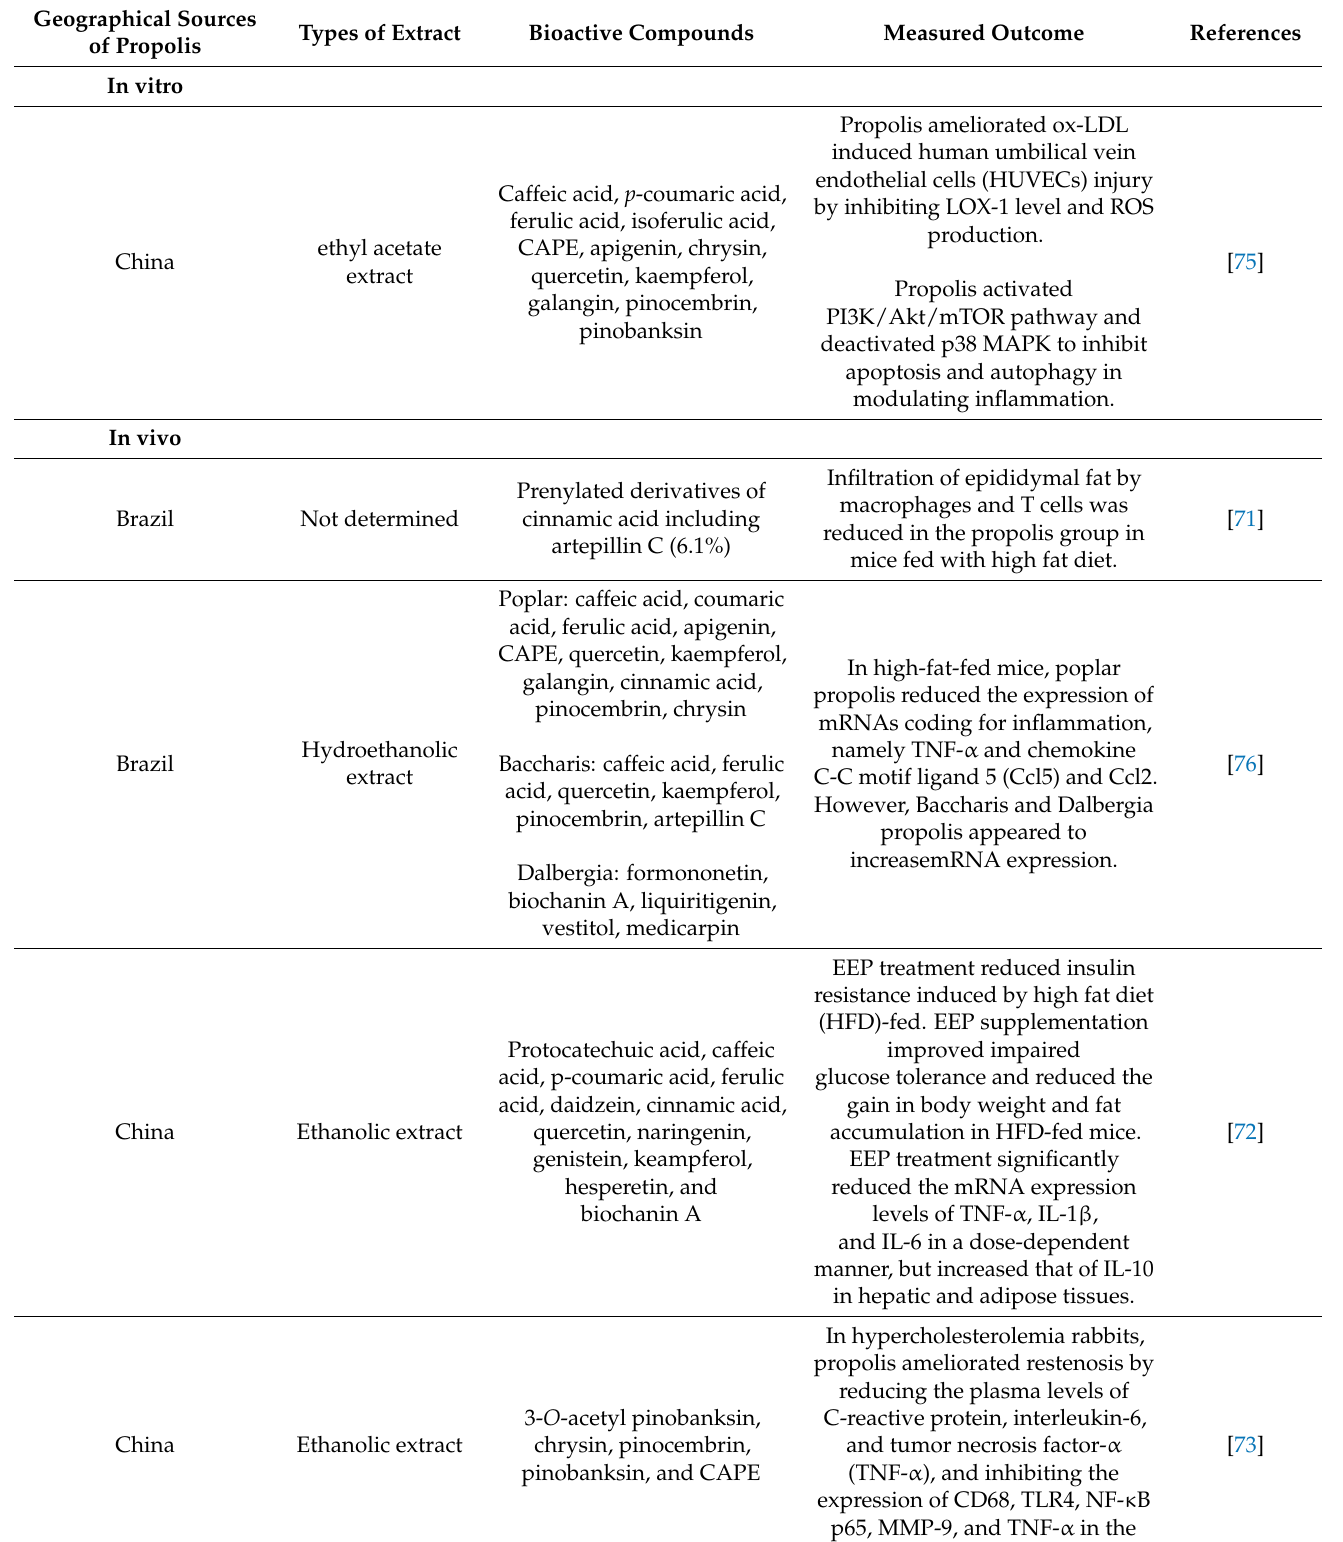
Table 4. Anti-inflammatory properties of propolis inmetabolic syndrome-related disorders and